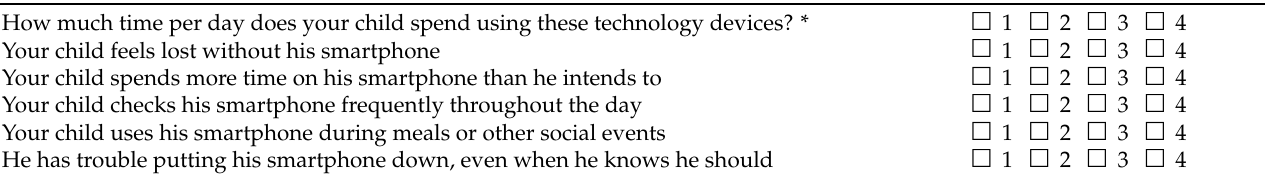
Table 2. Smartphone Use Questionnaire adapted for hetero-evaluation.